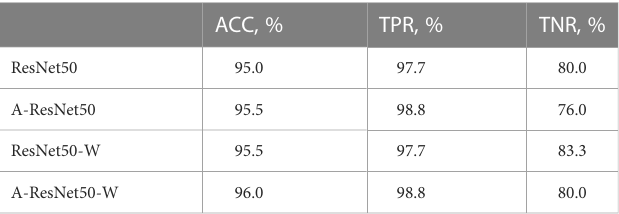
TABLE 4 Classi fi cation performance of different